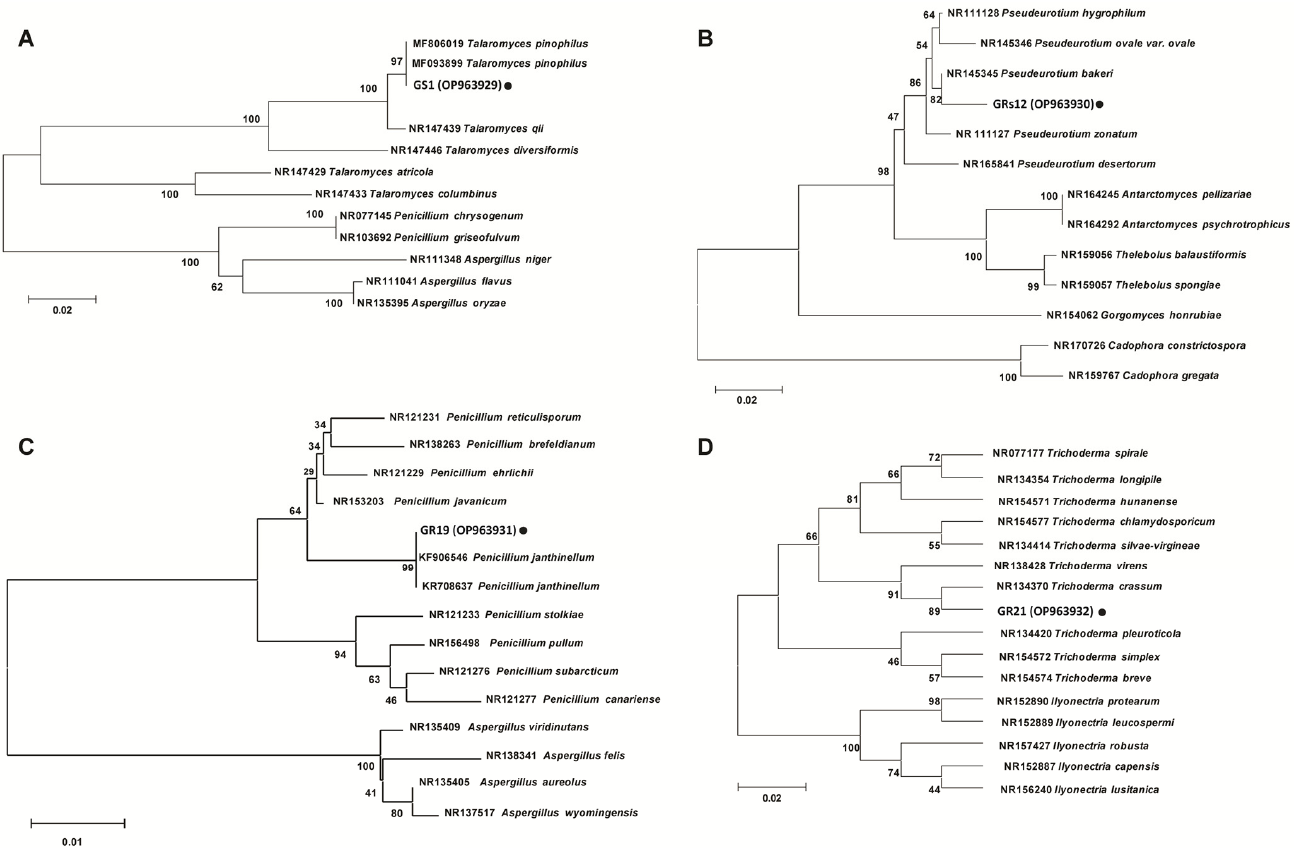
Figure 2. Phylogenetic trees of plant growth-promoting fungi based on internally transcribed spacer sequence. ( A ) GS1 strain. ( B ) GRs12 strain. ( C ) GR19 strain. ( D ) GR21 strain. The trees were constructed by MEGA 6.0 using neighbor-joining analysis of 1000 bootstrap replications.